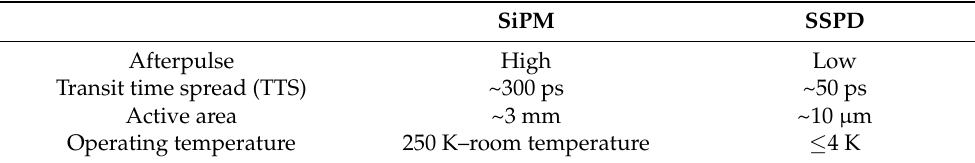
Table 4. Characteristics of emerging photodetectors [24,27].